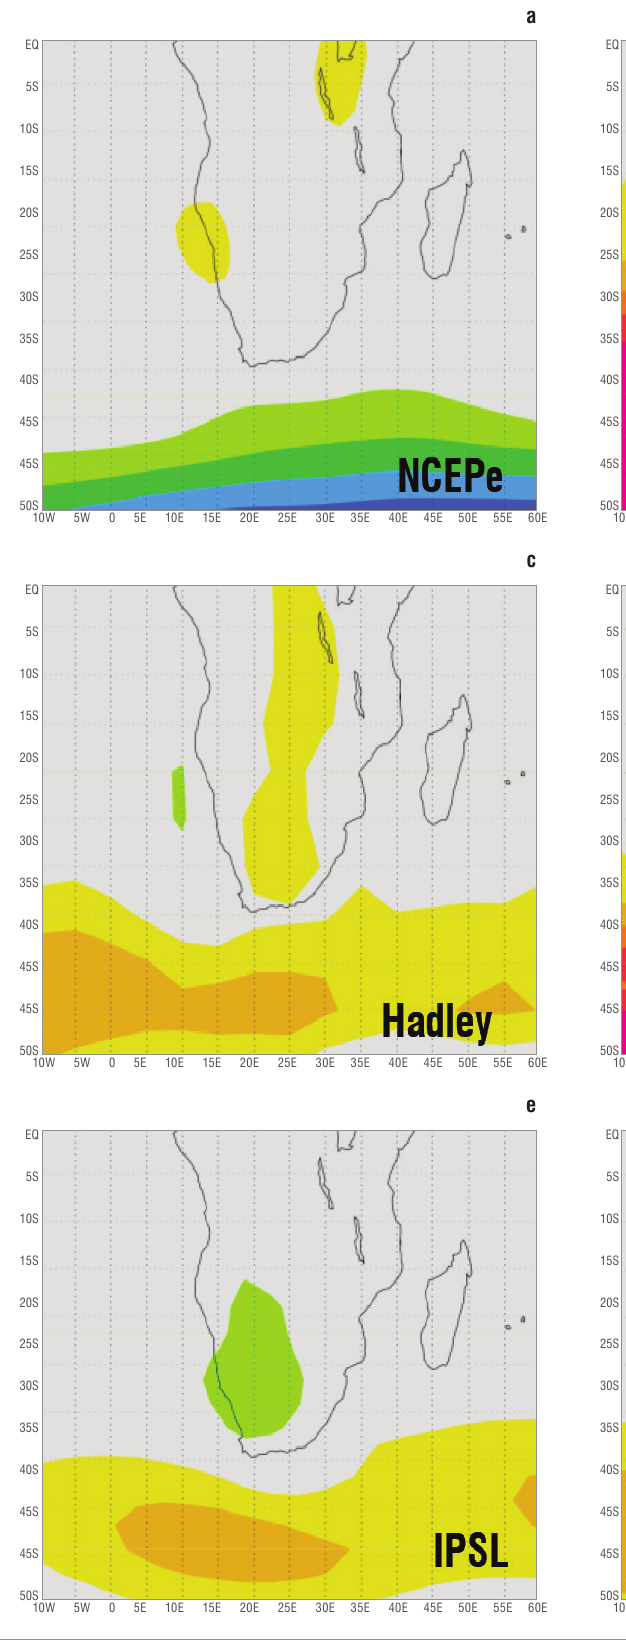
Note: scales for model simulations differ. Circles in (f) are key points analysed in Figure 5. Figure 4: Sea level pressure trends (mb/year) over southern Africa obtained through linear regression for (a and c) 1900–2010, (b) 1958+, (d) 1979+, and (e and f)